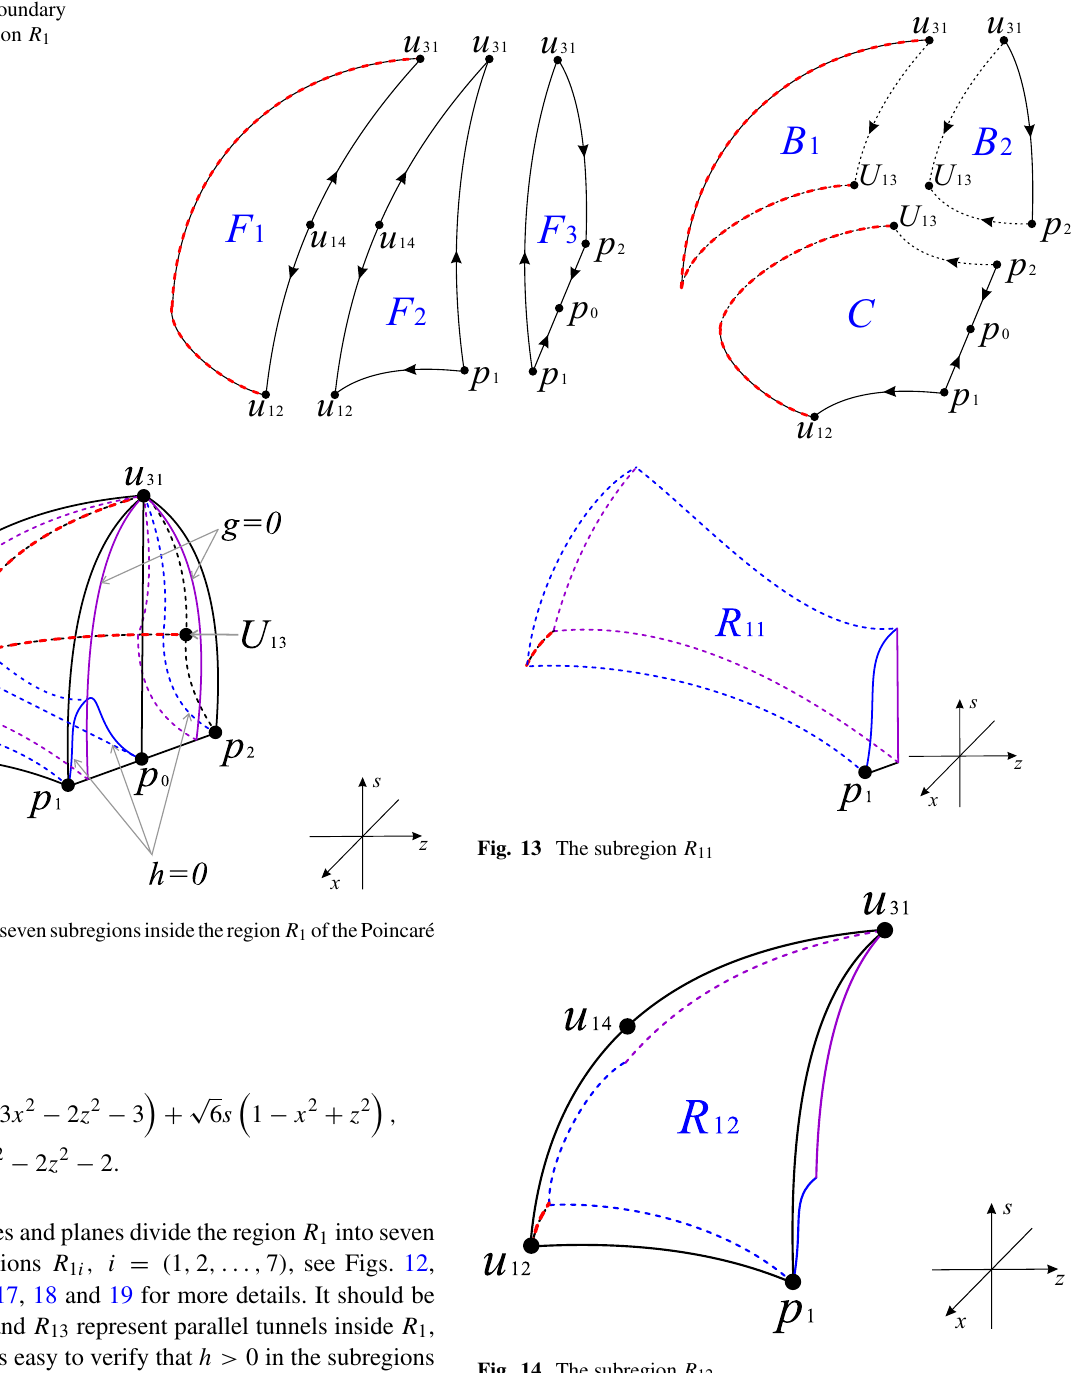
Fig. 14 The subregion R